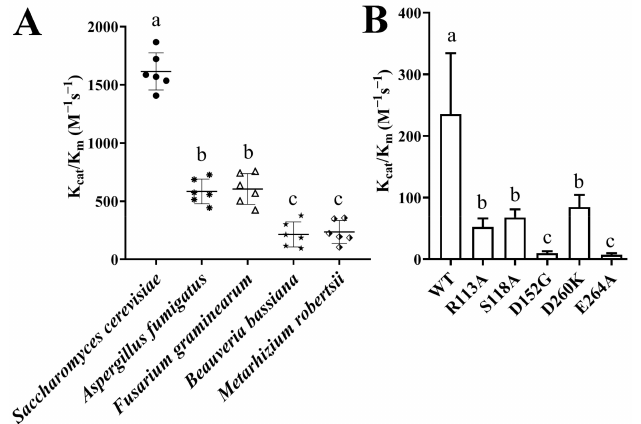
Figure 2. Kinetic parameters of ILVCs. ( A ) Kinetic parameters of different fungal ILVCs. ( B ) Kinetic parameters of MrILVC and its mutants. Different lowercase letters marked on the bars in each graph denote significant differences ( p < 0.05). Error bars, standard deviation from six replicate